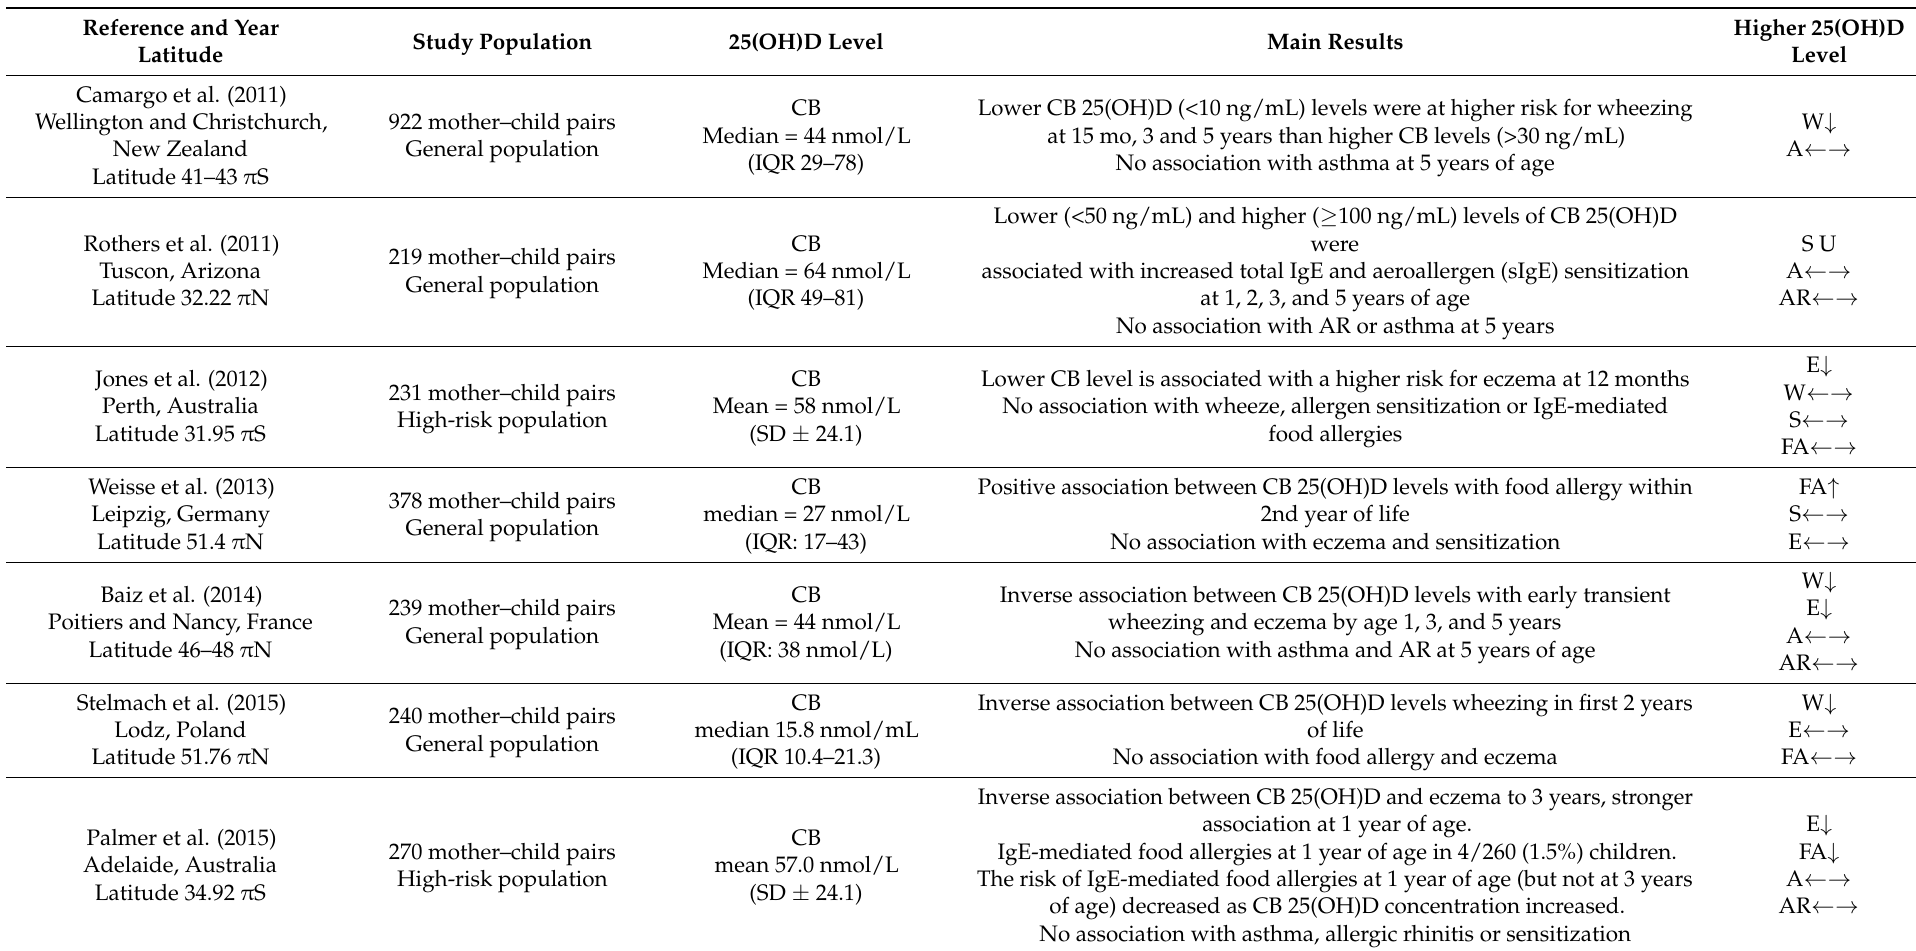
Table 1. Prospective birth cohort studies of 25(OH)D cord blood (CB) levels and allergy outcome in